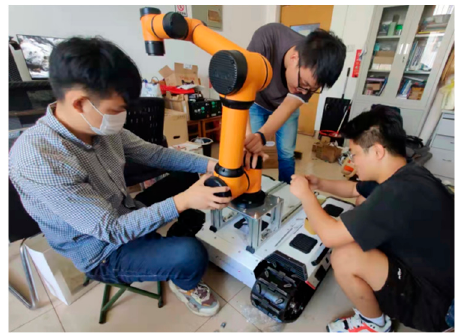
Figure 9. Construction of test platform.